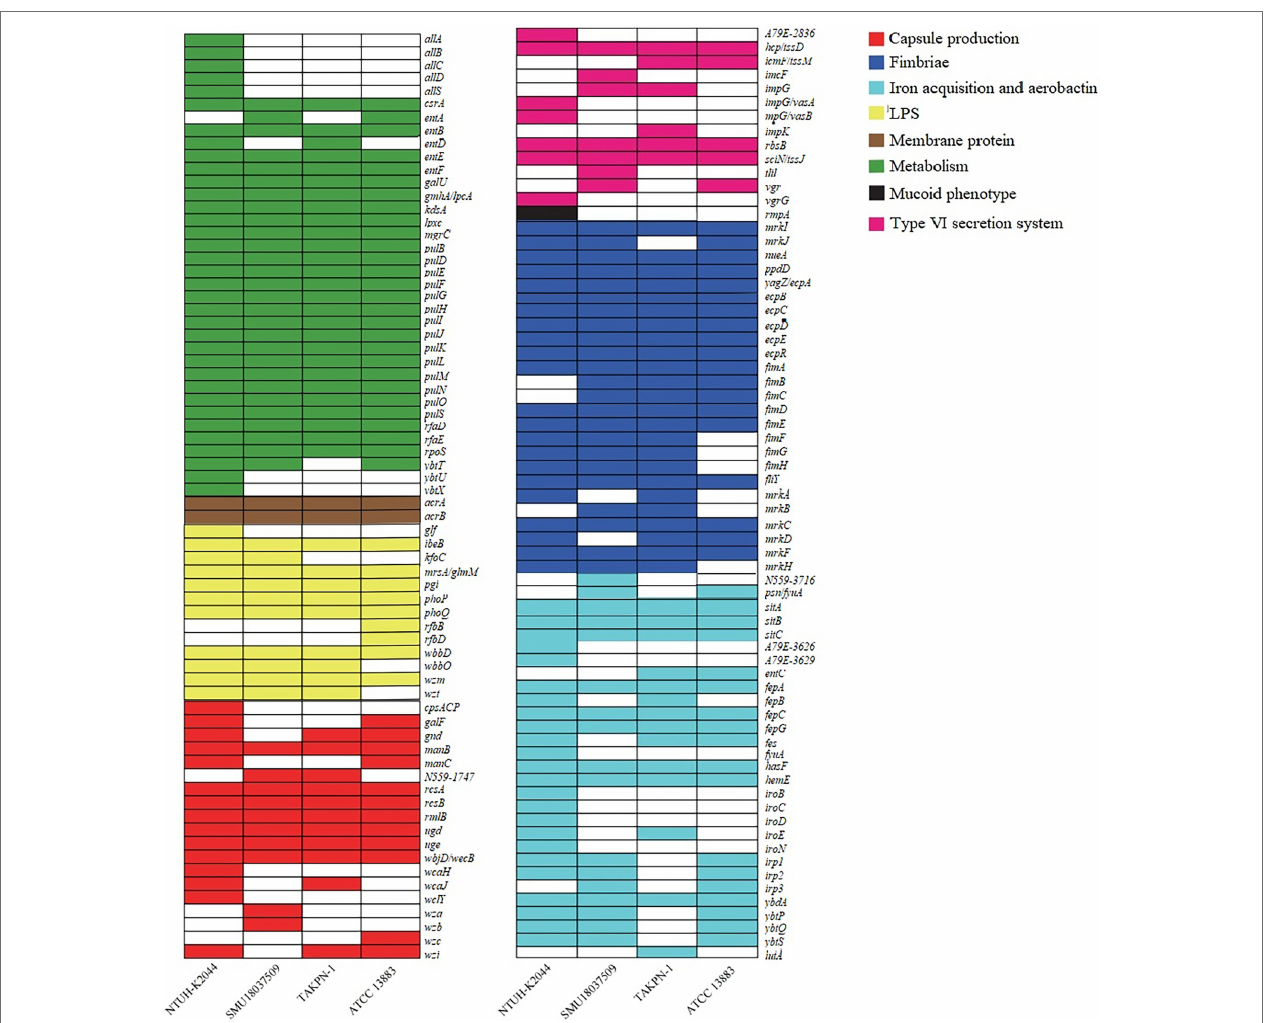
Supplementary Figure S1 | PFGE results for 3 hvKP